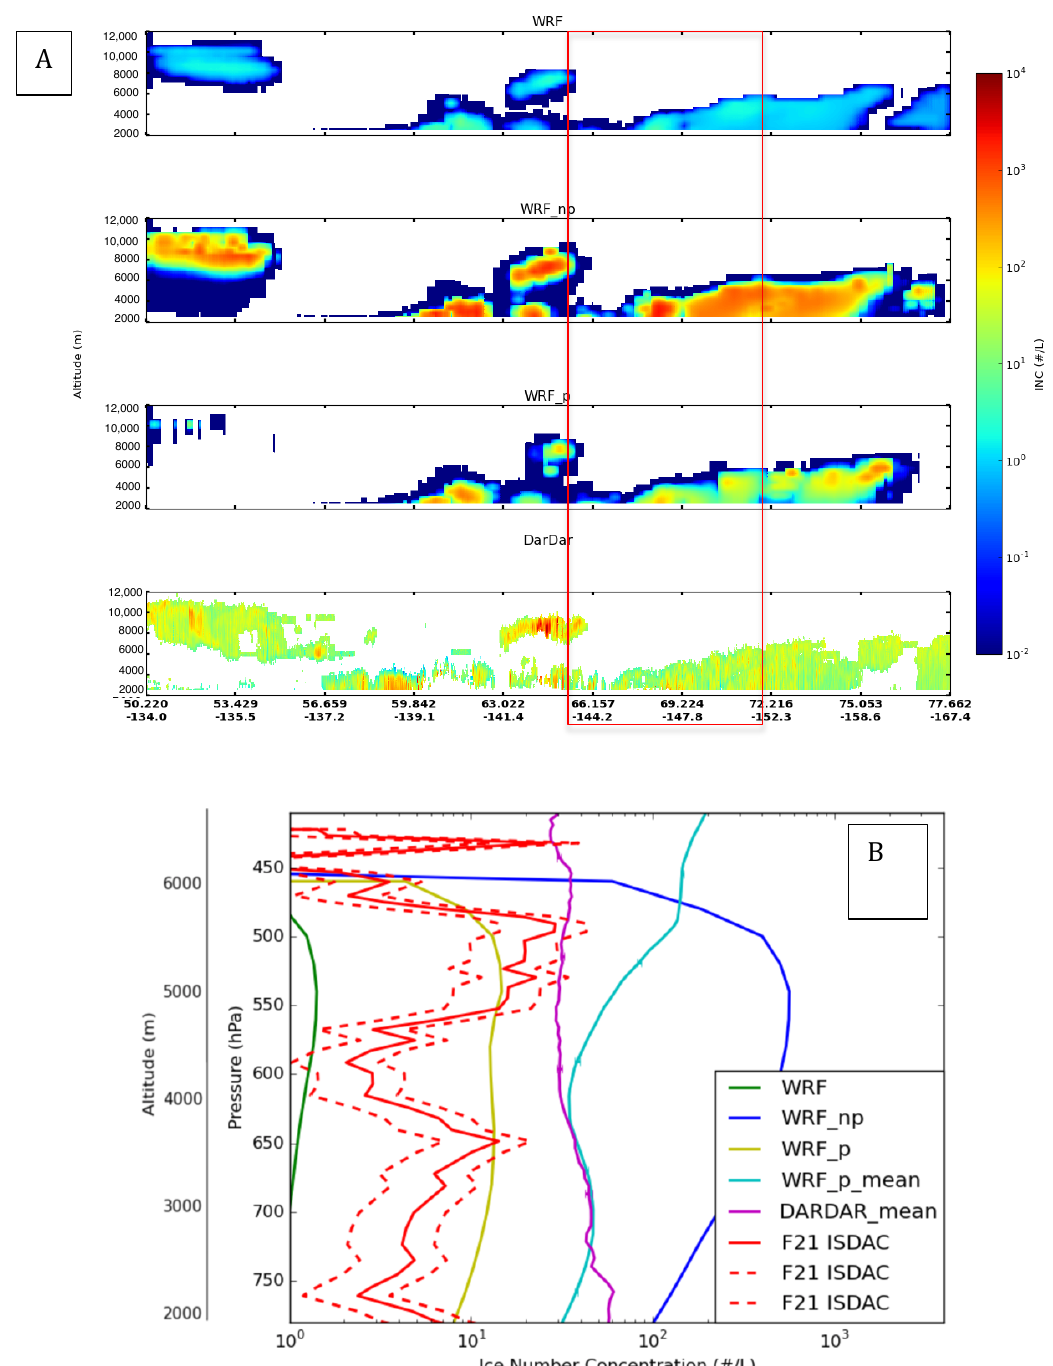
Figure 12. Observed and simulated (WRF, WRF_np and WRF_p) Ni along T21 track ( A ) and F21 flight ( B ). Simulated profile WRF_p_mean averaged along the satellite track over the larger domain of Figure 1 is also shown on ( B ) together with DARDAR-retrieved average profile. The dashed red line on (B) represents the variability (standard deviation) of ISDAC